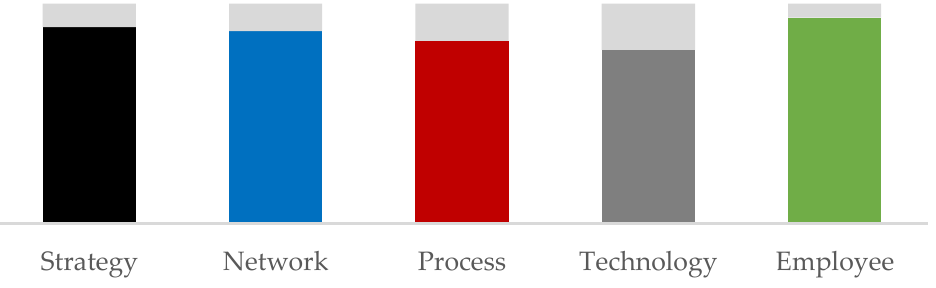
Figure 13. Level of the five logistics dimensions for the expert profile.